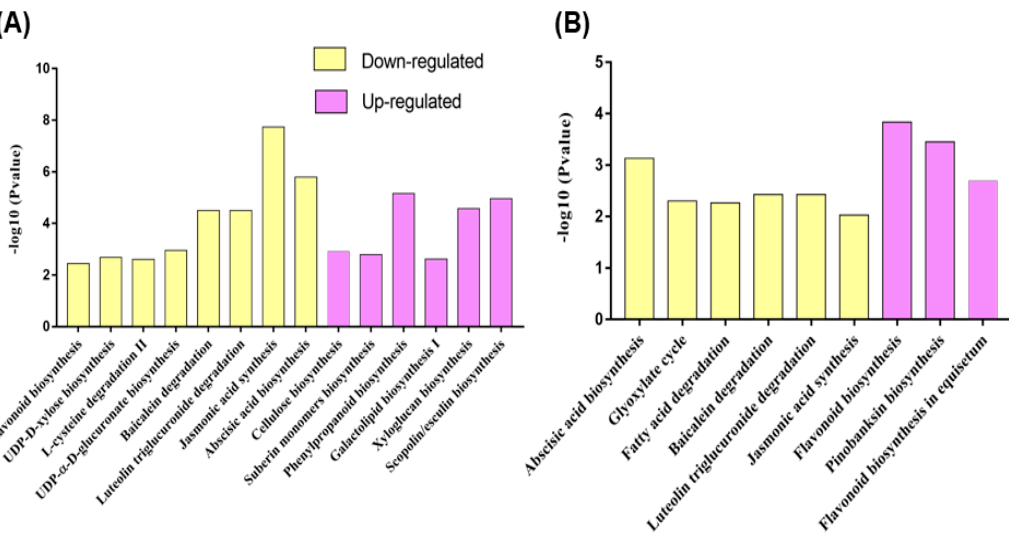
Figure 7. Pathway enrichment analysis of the upregulated and downregulated genes under ToLCNDV-India ( A ) and ToLCNDV-ES infection ( B ). Defense hormones, such as jasmonic acid and abscisic acid, were downregulated, while the genes related to the flavonoid pathway showed con- trary expression under the two infections. contrary expression under the two